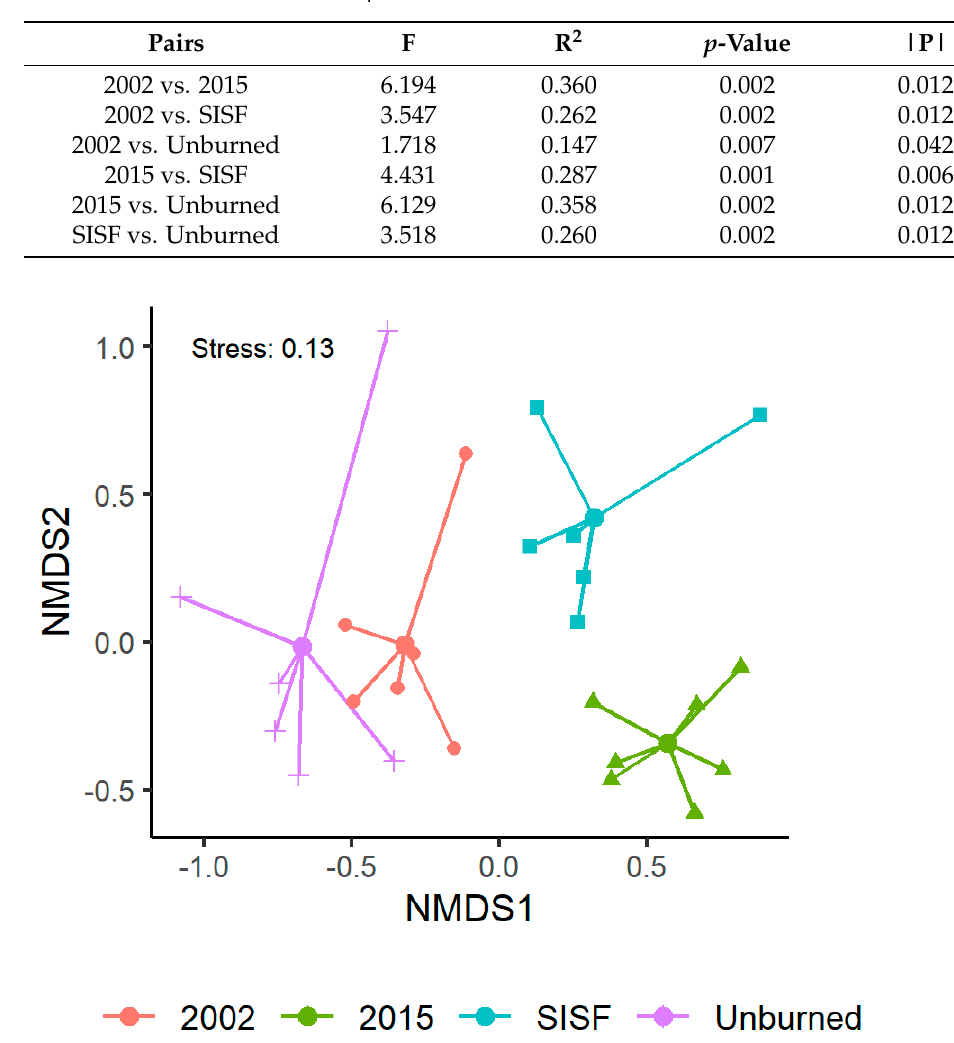
Figure 3. Non-metric multidimensional scaling (NMDS) visualization of species composition between fire conditions.